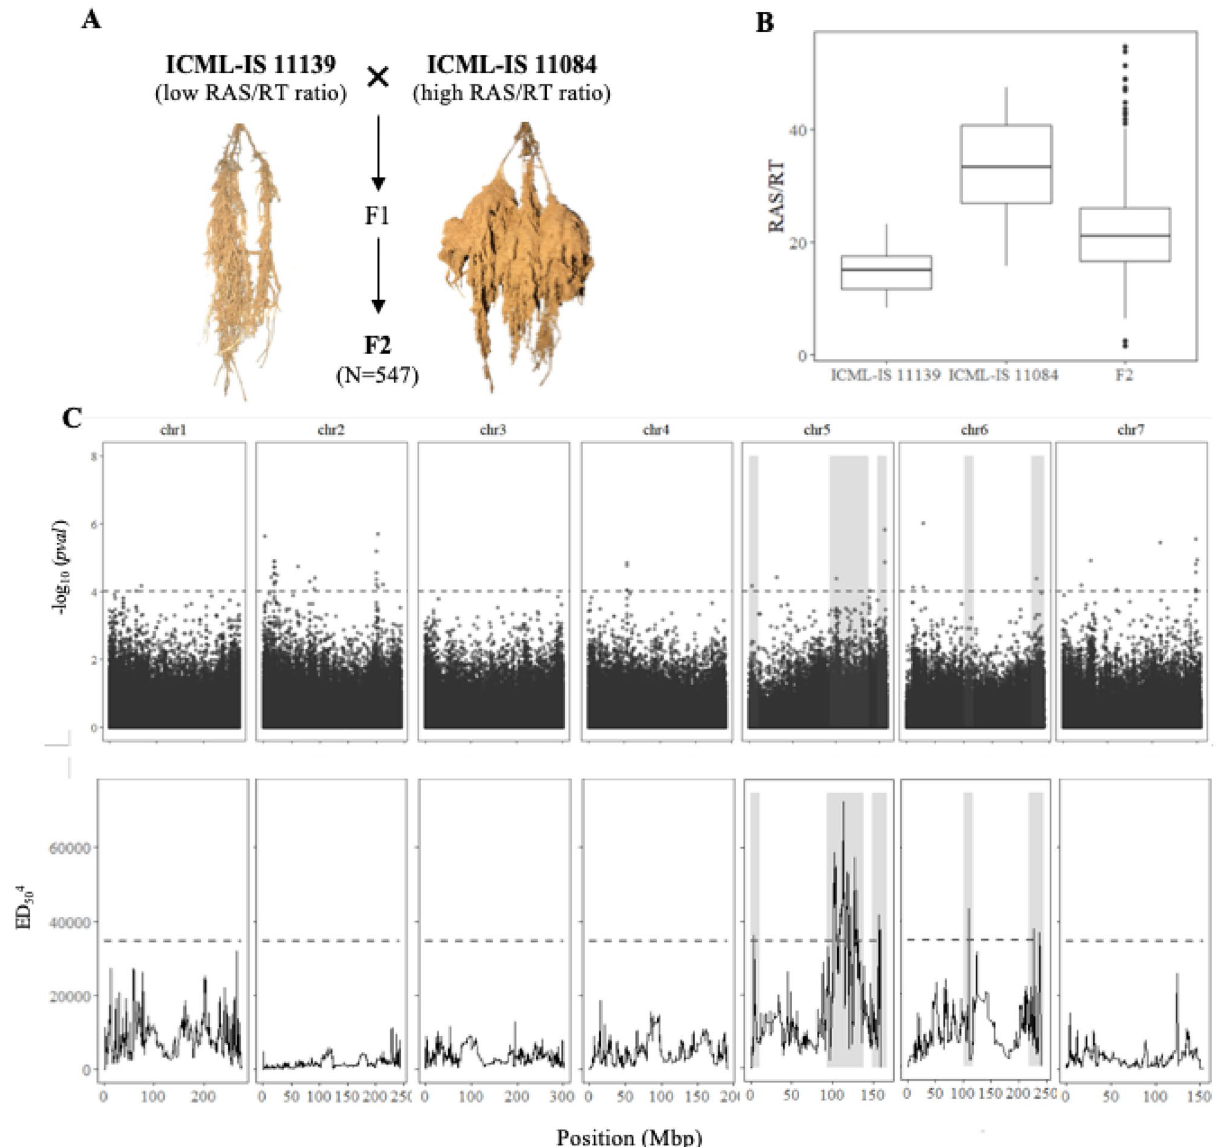
Figure 3. Genetic dissection of root soil aggregation in pearl millet by Bulk Segregant Analysis (BSA). ( A) Cross established for Bulk Segregant Analysis (BSA) between two pearl millet inbred lines with contrasted rhizosheath phenotype. ( B) Boxplot showing the distribution of RAS/RT ratio in line ICML-IS 11139 (N = 29), ICML-IS 11084 (N = 27) and F2 population (N = 547). ( C) Comparison between GWAS and BSA results. Top figure represents the Manhattan plot of the GWAS by LFMM ridge method 36 . The x-axis corresponds to the position of the 381,899 SNPs identified by GBS in a group of 139 inbred lines. The vertical axes correspond to the –log10 p value of the statistic. The dashed line delimits the threshold for highly significant SNPs ( p value < 10 –4 ). Bottom figure shows the significant regions associated with root soil aggregation identified by BSA using bulks of contrasted F2 lines from a bi-parental cross. The plot shows the Euclidean Distance statistic profile (y axis) across the seven pearl millet chromosomes (x axis). The dashed line indicates the 95% confidence interval threshold for the localisation of significant regions. In both plots, the shaded area delimits the extent of the five significant regions identified by BSA and the overlap with significant SNPs identified by GWAS and the correspondence with the BSA peaks